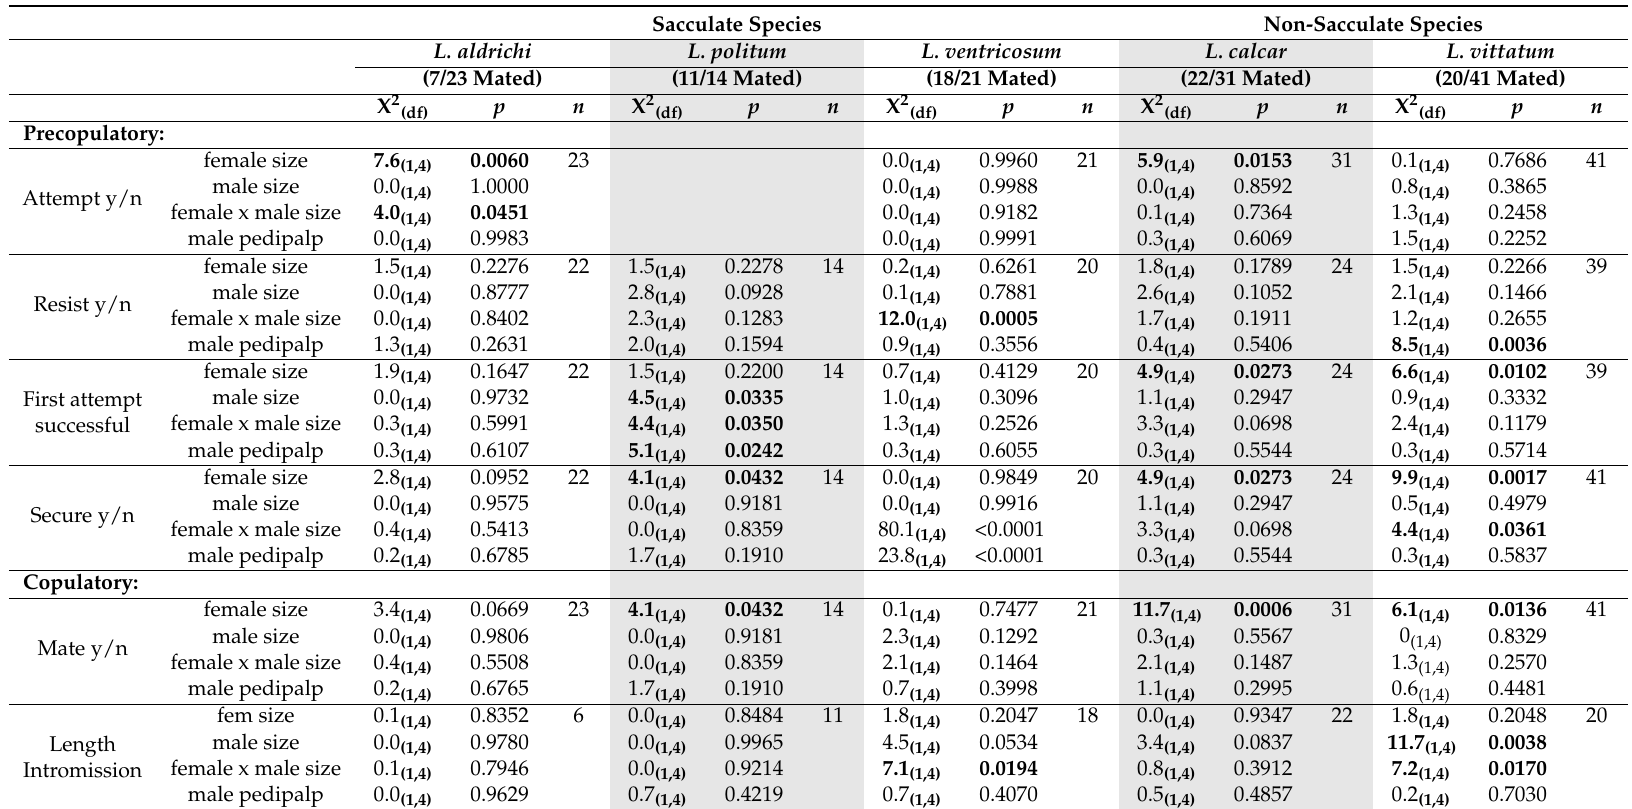
Table 3. Analyses testing for morphological predictors of various stages of mating in five species of leiobunum harvestmen. All of the models were either nominal logistic regressions or linear regressions. Bolded values indicated p < 0.05, and ‘n’ indicates the number of trials included in each analysis. The gray text in L. aldrichi indicates there was only one male that did not attempt. Sacculate species are on the left, and non-sacculate species are on the right, with the continuum of antagonism going from low antagonism to high antagonism, from left to